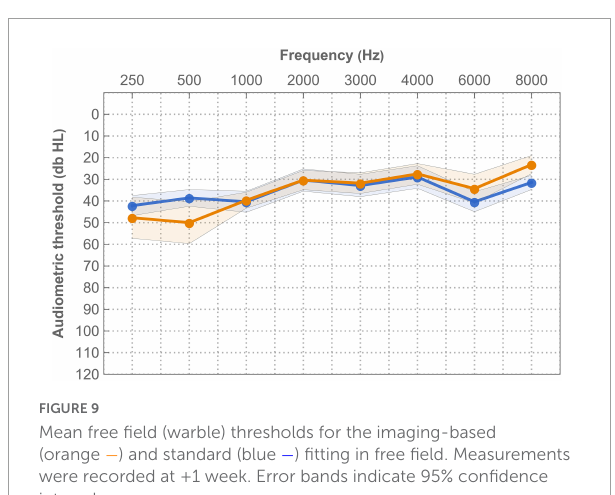
FIGURE9 Mean free field (warble) thresholds for the imaging-based (orange − ) and standard (blue − ) fitting in free field. Measurements were recorded at +1 week. Error bands indicate 95% confidence